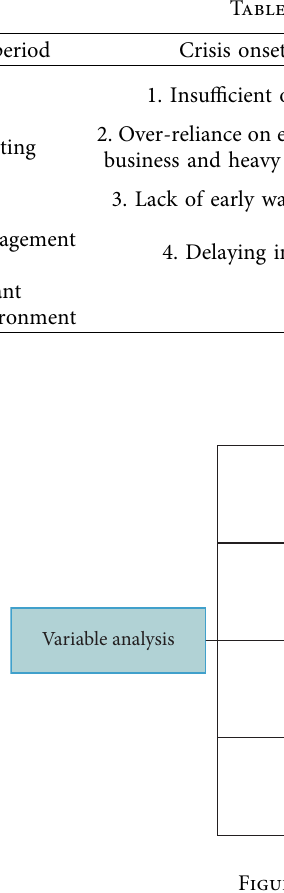
Table 2: The “four-stage symptom” analysis.